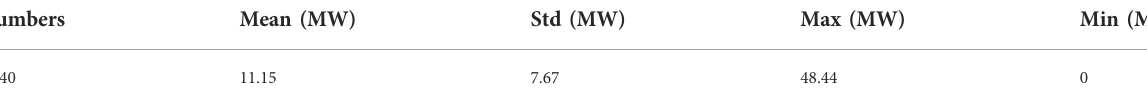
TABLE 1 The basic information of data set.